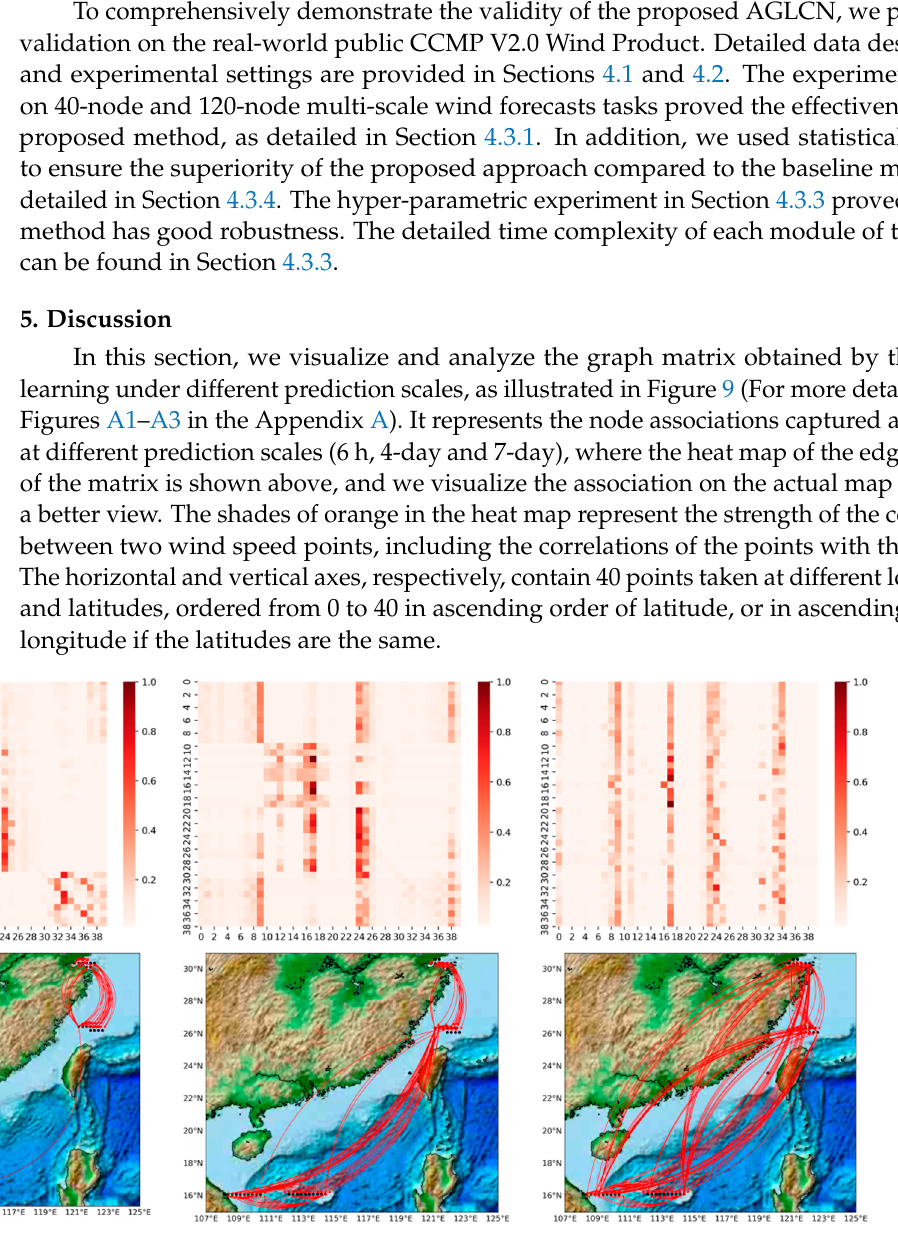
Figure 9. The learned graph structure at different prediction scales (40-nodes).